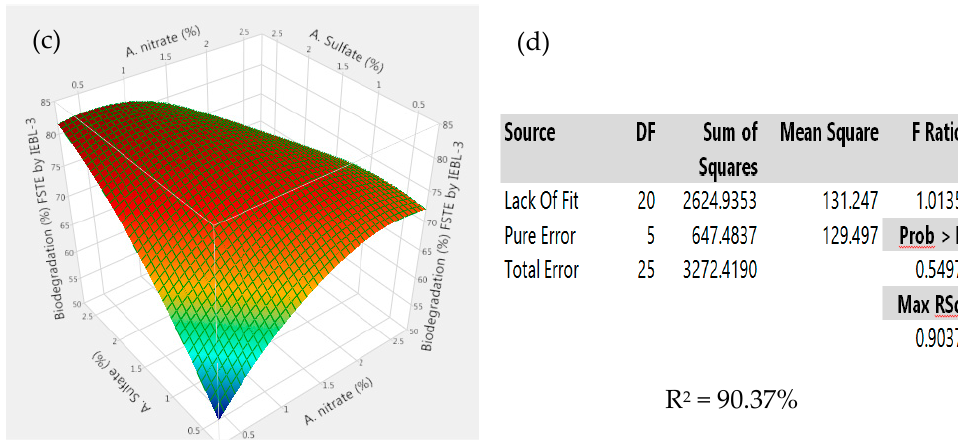
Figure 6. Response surface 3D graphs showing effect of carbon and nitrogen sources on the biodegradation of Five Star Textile (MT) industrial effluent by P. betulinus IEBL ‐ 3; graphs represent positive interaction between ( a ) ammonia and fructose, ( b ) ammonia and a. nitrate and ( c ) a. sulfate and a. nitrate. ( d ) Statistical analysis indicating the significant effect of parameters.